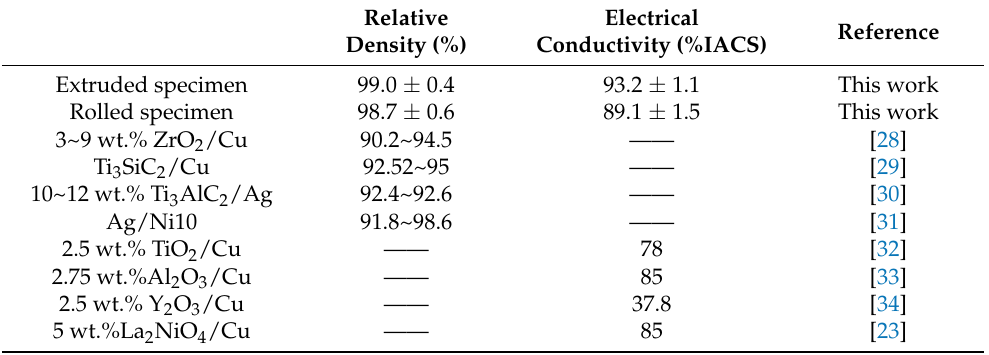
Figure 3. Optical images of the CdMoO 4 /Cu composites by powder metallurgy: ( a ) the hot-extrusion state and ( b ) the rolling state. CdMoO 4 particles are indicated by red dashed circles. Table 1. Relative density and electrical conductivity of CdMoO 4 -reinforced Cu-based composites.